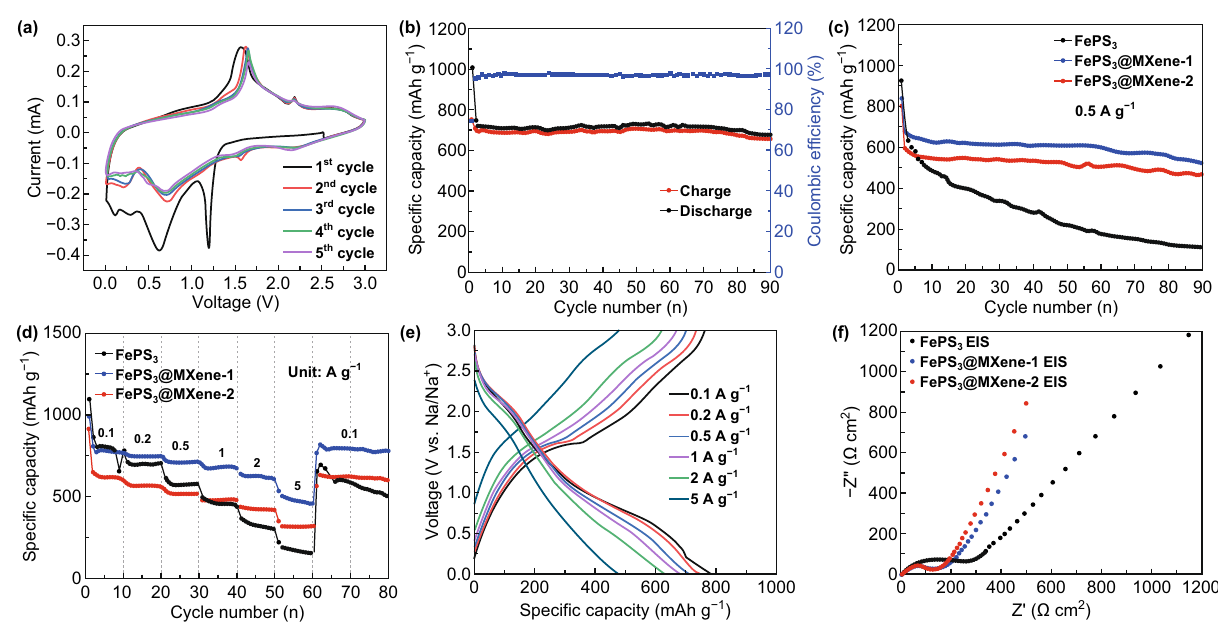
Fig. 5 Electrochemical performance comparison for SIBs. a CV profiles for the five cycles at 0.1 mV s −1 . b , c Cycling stability at 0.1 and 0.5 A g −1 . d Rate capabilities. e GCD profiles at various current densities. f Nyquist